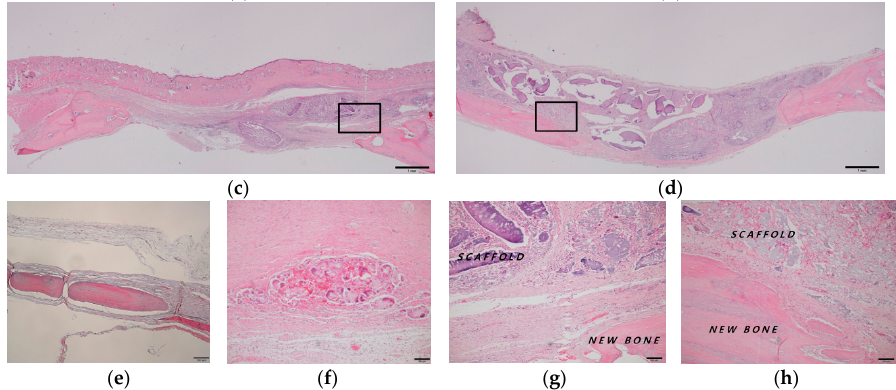
Figure 5. Histological images (hematoxylin and eosin staining) at eight weeks after operation. ( a ) unfilled defect in the control group (bar = 1 mm). ( b ) AL (bar = 1 mm), ( c ) AL/HA (bar = 1 mm), and ( d ) AL/HA/SF (bar = 1 mm) composites. ( e – h ) are magnified views of the boxed areas in ( a – d ) (original magnification 100 × , bar = 100 µ m).